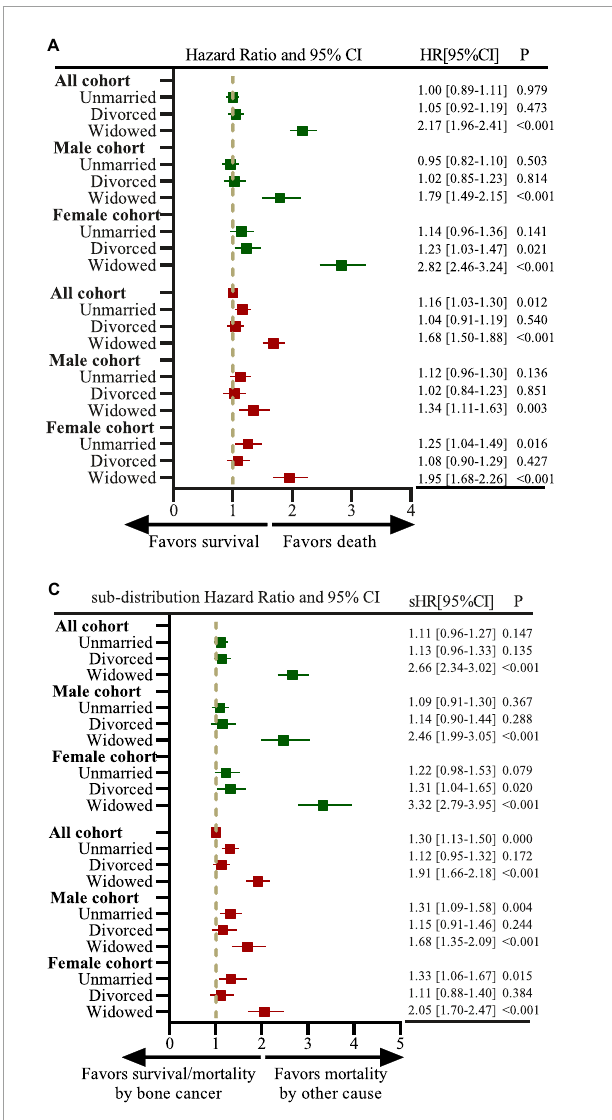
FIGURE2 Forest plots depicting hazard ratios (HRs) and 95% confidence intervals (CIs) for analyzing the impact of marital status on all-cause mortality based on the Cox proportional hazards regression model and mortality owing to bone cancer and other cancers based on the Fine-and-Gray competing risk model. (A) Impact of marital status on all-cause mortality in all, male and female cohorts; (B) impact of marital status on mortality owing to bone cancer in all, male and female cohorts; (C) impact of marital status on mortality owing to other cancers in all, male and female cohorts. The dark green color represents the results of univariate analysis, and the brown color represents the results of multivariate